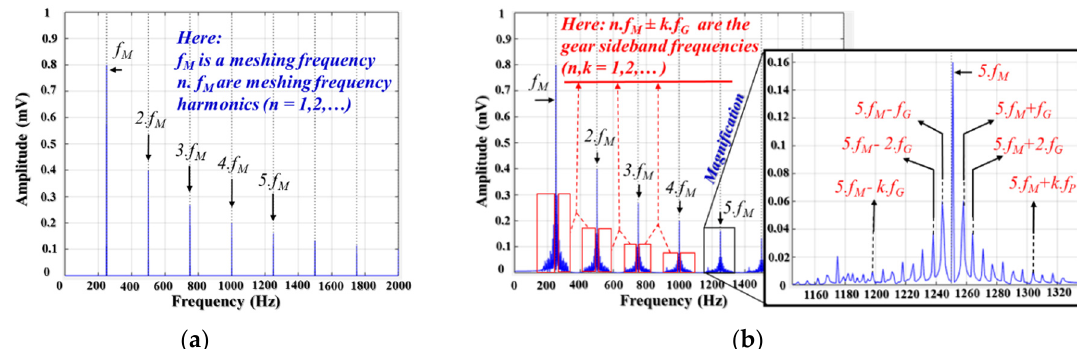
Figure 2. The frequency spectrum of the gearbox vibration signal: ( a ) a healthy gearbox and ( b ) a faulty gearbox.